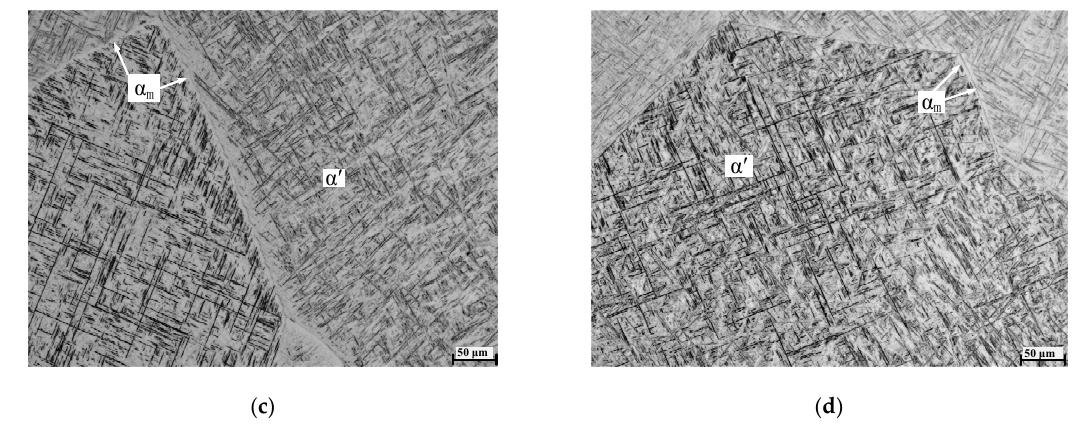
Figure 3. OM images of two kinds of samples after the rapid cooling at 80 °C/s: ( a ) and ( c ) correspond to the sample processed at the heating rate of 0.3 °C/s; ( b ) and ( d ) correspond to the sample processed at the heating rate of 0.8 °C/s.